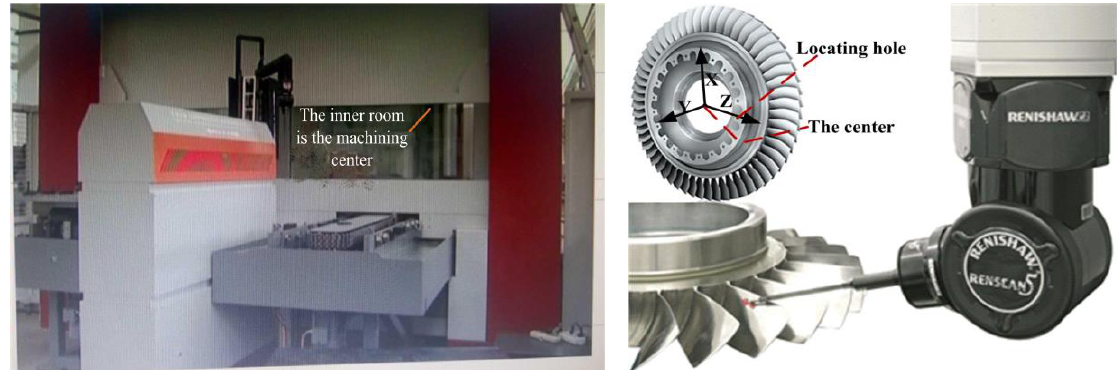
Figure 11. The applied coordinate measuring system: the left picture is the scene photo; and the right picture is the measurement on the workpiece.